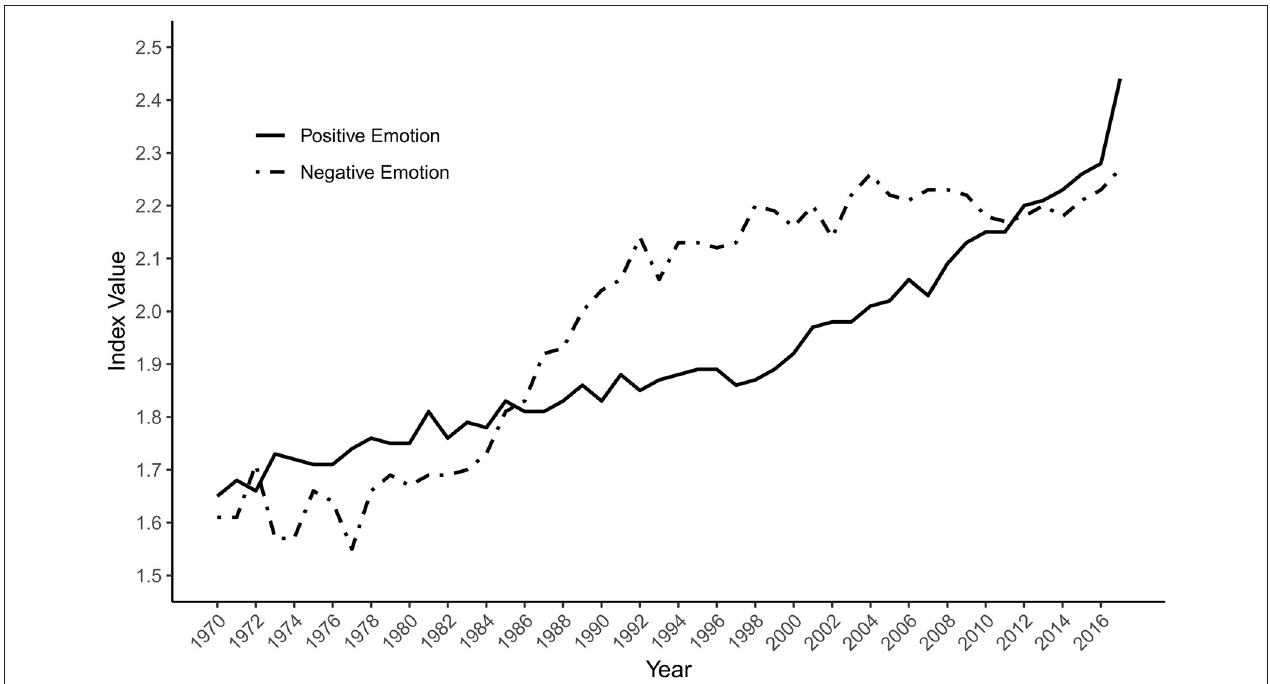
FIGURE 1 | The positive emotion and negative emotion indices by year.